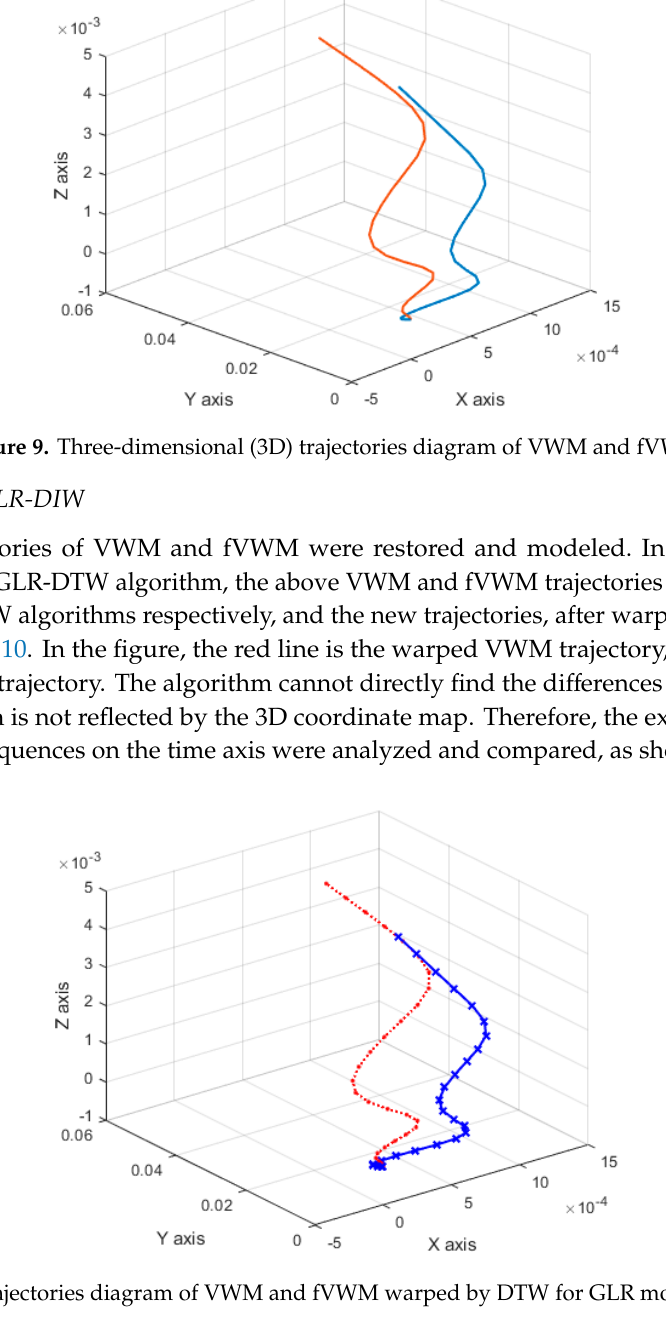
( d ) Figure 7. Collected raw signals of wave-shape movement at the two speeds. ( a ) Acceleration (ACC) signals of VWM, ( b ) ACC signals of fVWM, ( c ) Angular velocity (AV) signals of VWM, and ( d ) AV signals of fVWM. Figure 8a displays the waveform of VWM ACC signals after coordinate conversion, and Figure 8b shows the waveform of fVWM ACC signals after coordinate conversion. TSx, TSy and TSz represent the ACC signals of the x-, y-, and z-axis respectively, in the geographic coordinate system. The two figures only include the waveform of the effective movement interval for comparison and observation. Comparative analysis indicated that the ACC curves have shown a certain similar trend after the transformation of the two groups. ( a ) ( b ) Figure 8. ACC curves after coordinate conversion. ( a ) Curves of VWM and ( b ) curves of fVWM.